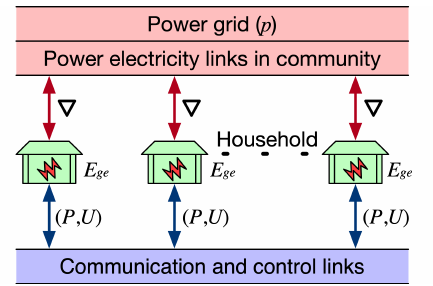
Figure 2. Peer-to-peer energy trading system